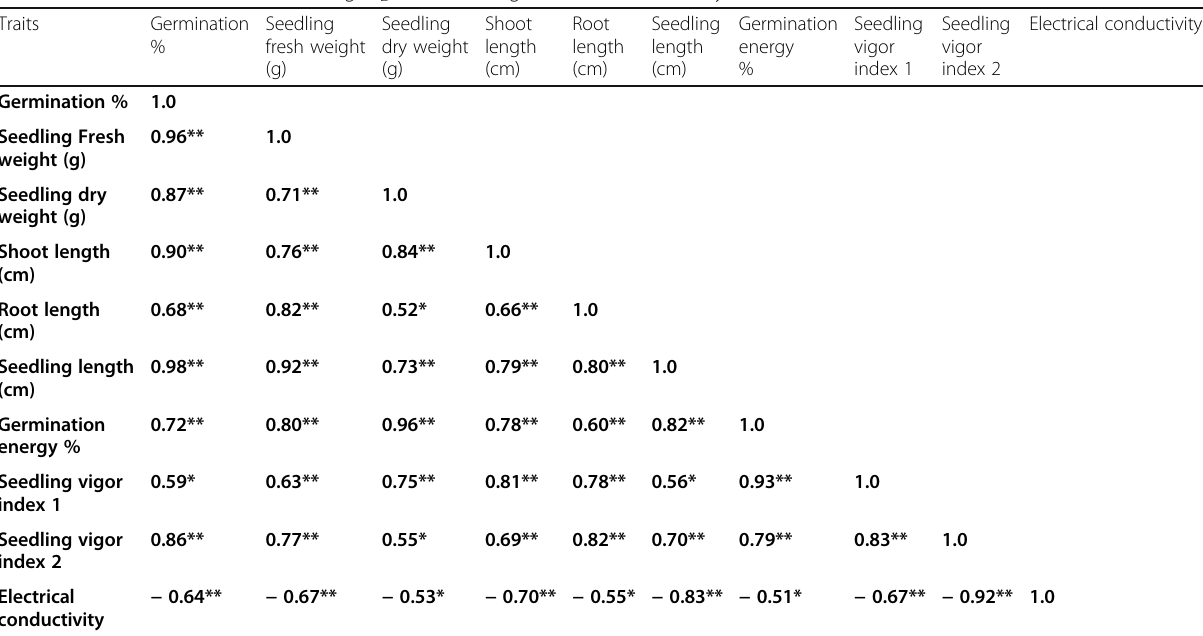
Table 6 Correlation coefficients among M 2 lentil seedling traits under 0.3% ethyl methane sulfonate (EMS) Traits